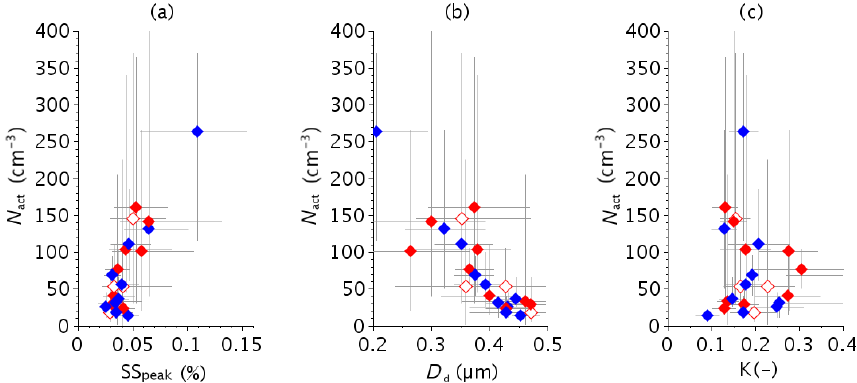
Figure 6. Number concentration of activated particles N act as a function of (a) the critical supersaturation, (b) the dry critical diameter and (c) κ for the 23 fog cases. Diamonds correspond to mean values and error bars to uncertainty intervals. The same symbols as in Fig. 2 are used.